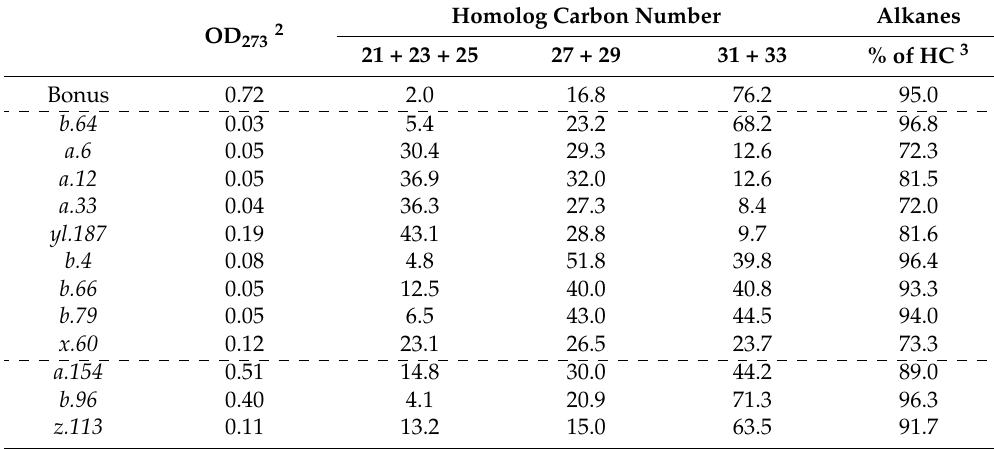
Table 5. ODs and alkane homolog distributions in spike waxes from Bonus and 12 cer mutants 1 . Homolog Carbon Number Alkanes OD 273 2 21 + 23 + 25 27 + 29 31 + 33 % of HC 3 Bonus 0.72